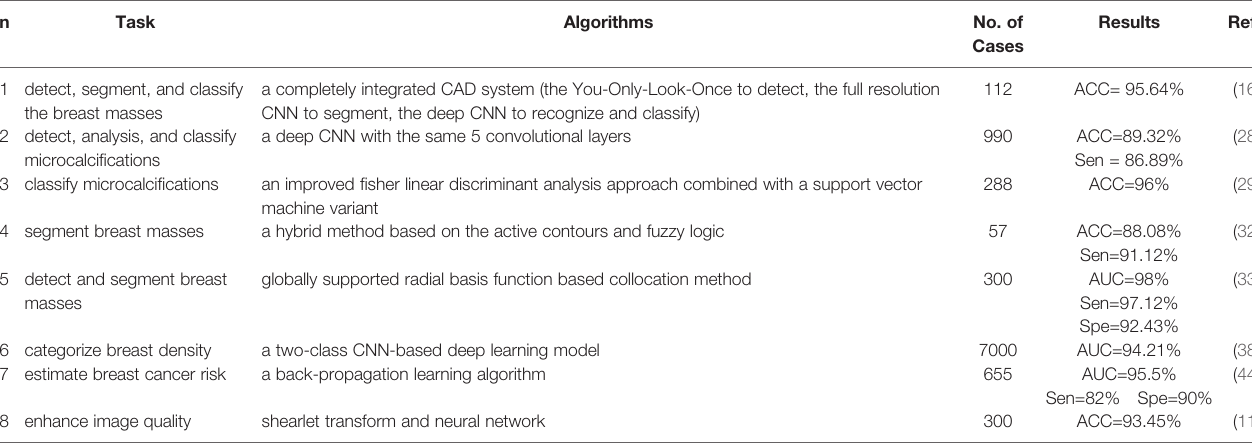
TABLE 1 | Summary of key studies on the role of AI in